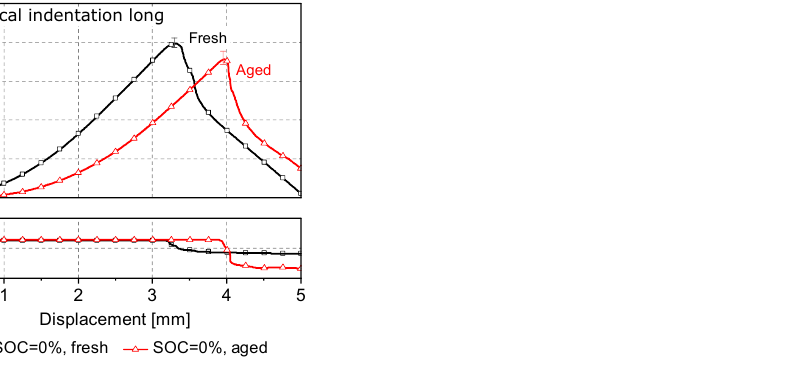
Figure 6. Comparison of the cylindrical indentation test results along the long cell side for fresh and electrically aged lithium-ion cells at 0%